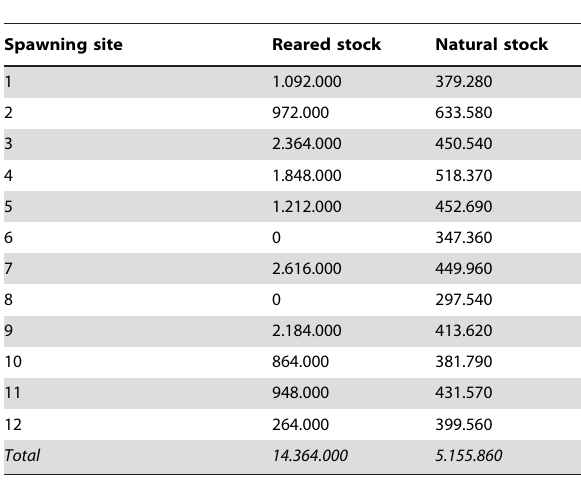
Table 2. Estimation of the reared and natural oyster stock, cumulated by spawning site (see Figure 3).